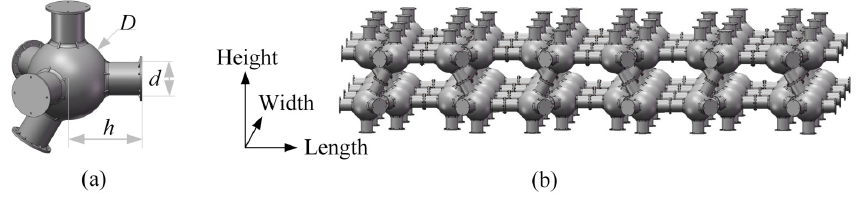
Figure 1. ( a ) The module named the five-pole unit; ( b ) a combination of multiple